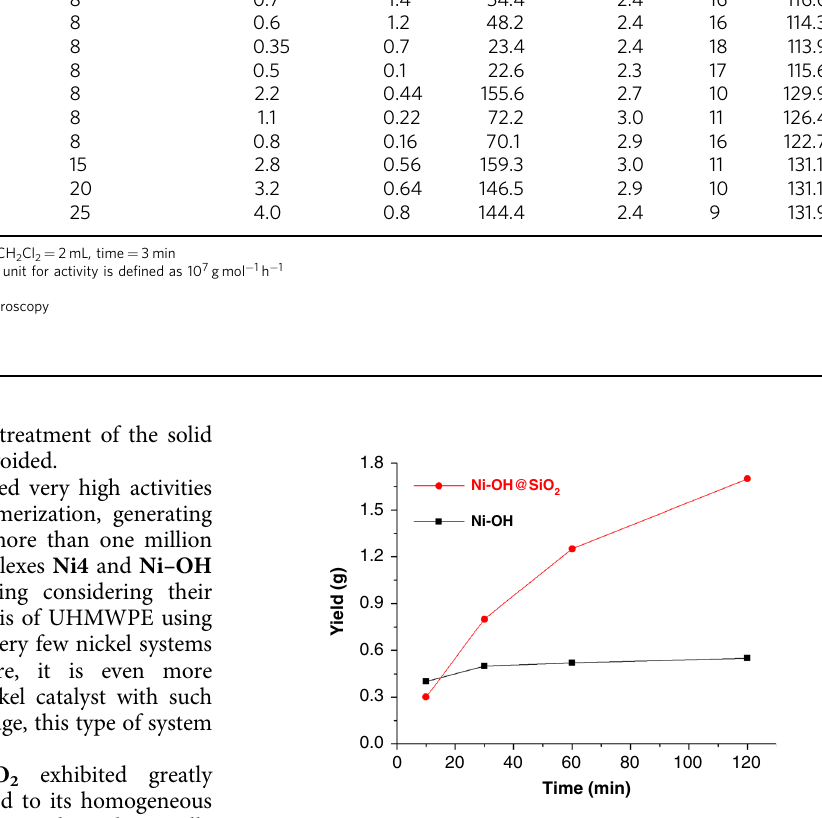
Fig. 5 Polymer yield as a function of time for Ni – OH@SiO 2 and Ni – OH. Ni – OH@SiO 2 is thermally more stable than Ni – OH in ethylene polymerization at 100 °C, and remained highly active within 120 min (homogeneous polymerization conditions: ethylene = 8 atm, catalyst = 1 μ mol, heptane = 29 mL, DCM = 1 mL; heterogeneous polymerization conditions: ethylene = 8 atm, catalyst = 1 μ mol catalyst supported on 100 mg of SiO 2 , heptane = 30